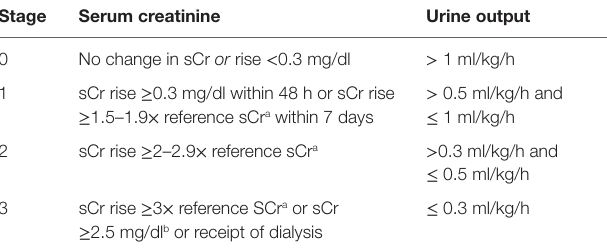
tablE 3 | neonatal acute kidney injury KdiGo classification